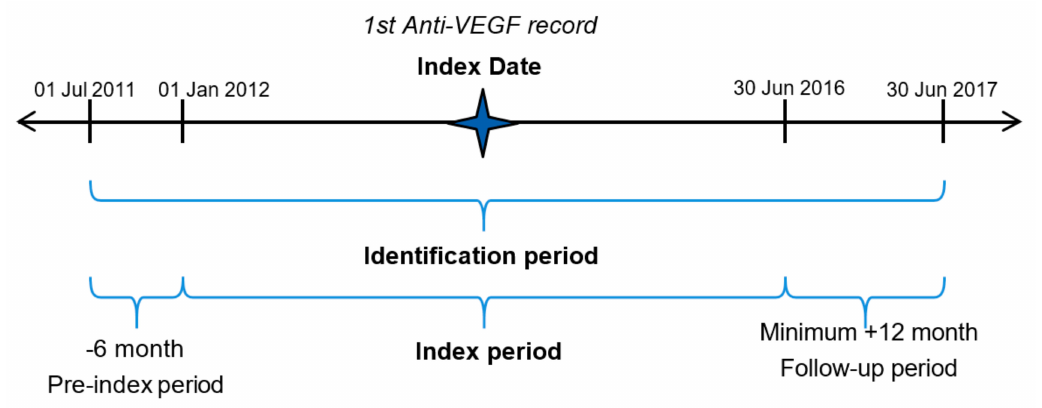
Figure 1. Study setting.